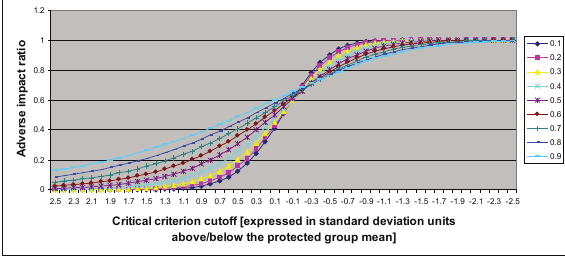
FIGURE 7 Adverse impact ratio as a function of the selection ratio and validity coefficient [difference in mean predicted criterion performance: 0,8 standard deviation